Question: Looking at the figure, what chart type is it?
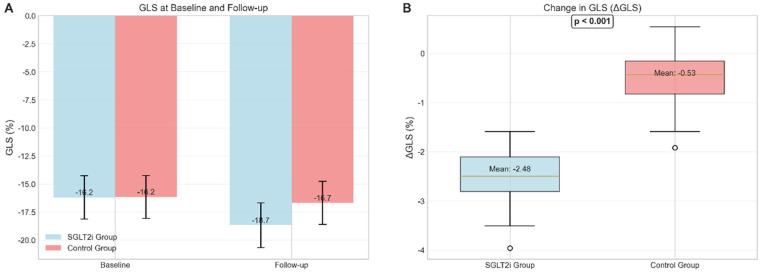
Answer: bar